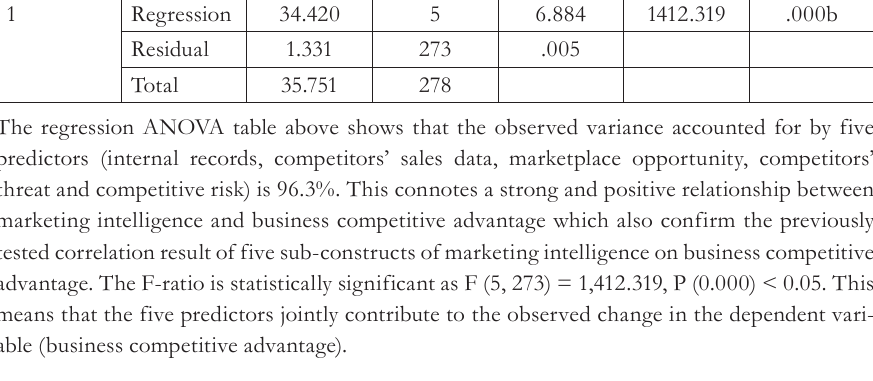
Tab. 8 - Coefficient Table for Marketing Intelligence and Business Competitive